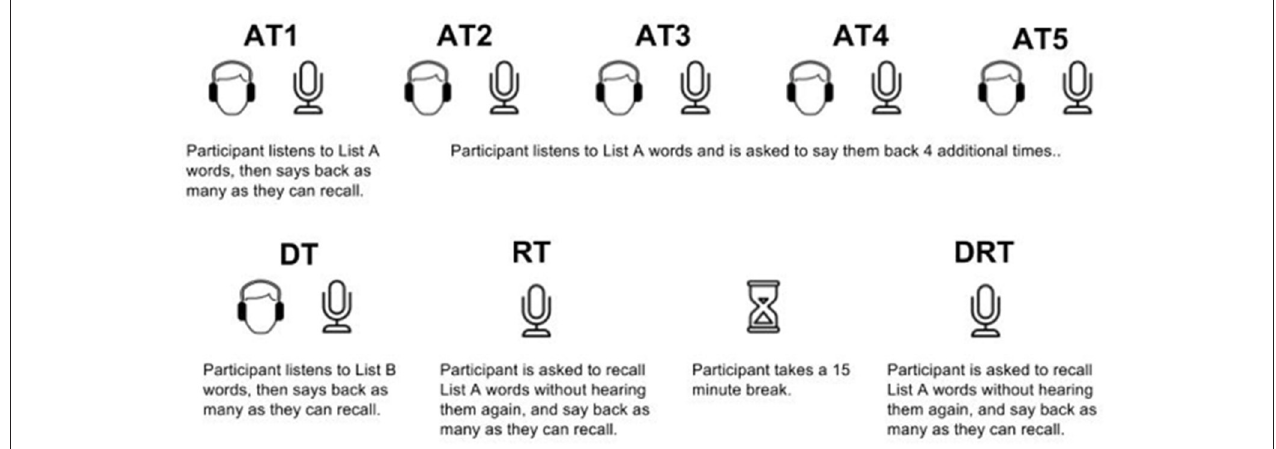
FIGURE 1 | Pictorial of conditions. (Illustrations by Yorlmar Campos, Romzicon, and Icon54 from the noun project).